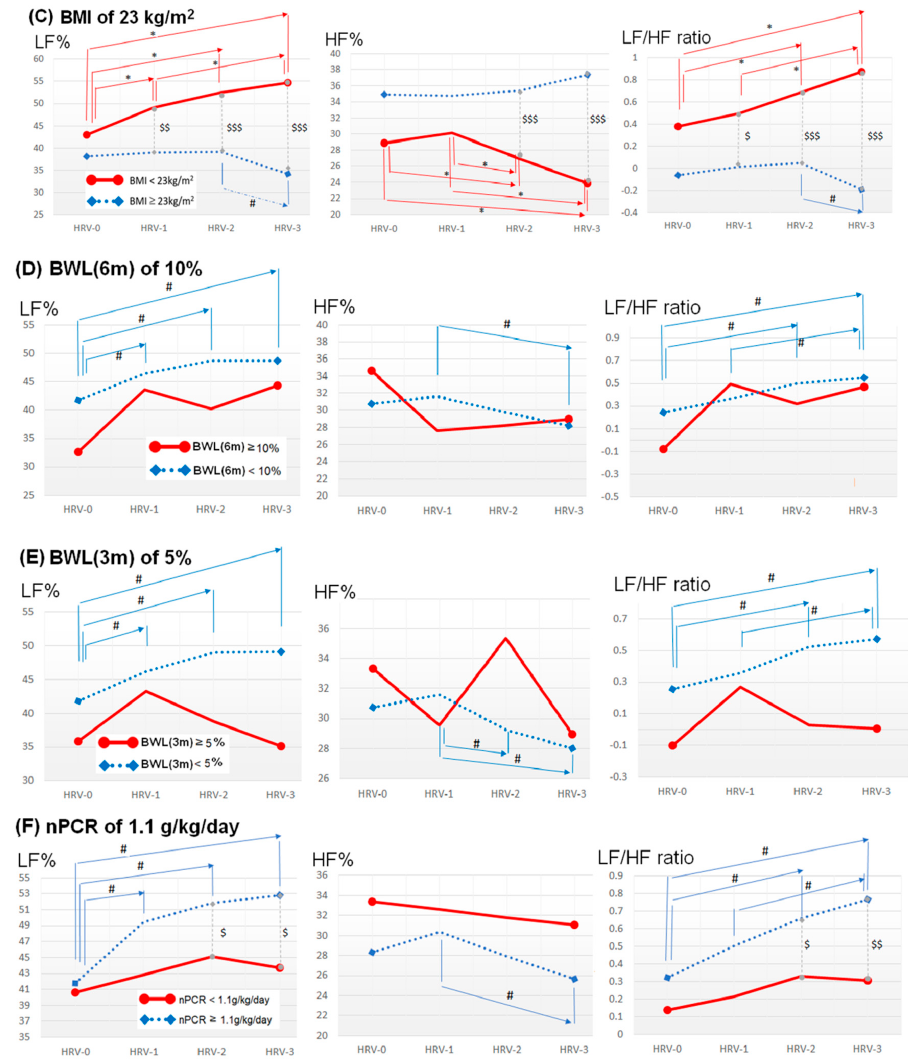
Figure 1. Serial changes of LF%, HF%, and LF/HF ratio of the two groups categorized by ( A ) serum albumin of 3.8 g/dL, ( B ) T ‐ Chol of 100 mg/dL, ( C ) BMI of 23 kg/m 2 ( D ), BWL (6m) of 10%, ( E ) BWL (3m) of 5%, and ( F ) nPCR of 1.1 g/kg BW/day. Independent and paired Student’s t ‐ test were used to compare the differences of HRV values between the two groups and between different phases of hemodialysis in the same group, respectively. The solid red line and dotted blue line indicate the serial changes of the individual HRV index (LF%, HF%, and LF/HF ratio) in patients with worse and better nutritional states, respectively. $, $$, and $$$ denote p < 0.05, 0.01, and 0.001, respectively, in the comparisons of HRV values at the same time points between two groups. * and # denote p < 0.05 in the comparisons of HRV values at different time points of the group with the worse and better nutritional state, respectively. Abbreviations: BMI: Body mass index; BWL (6 m): Bodyweight loss within six months; BWL (3 m): Bodyweight loss within three months; HF%: Normalized high frequency; LF%: Normalized low frequency; LF/HF ratio: Low ‐ frequency/high ‐ frequency ratio; nPCR: Normalized protein catabolic rate; T ‐ Chol: Total cholesterol.